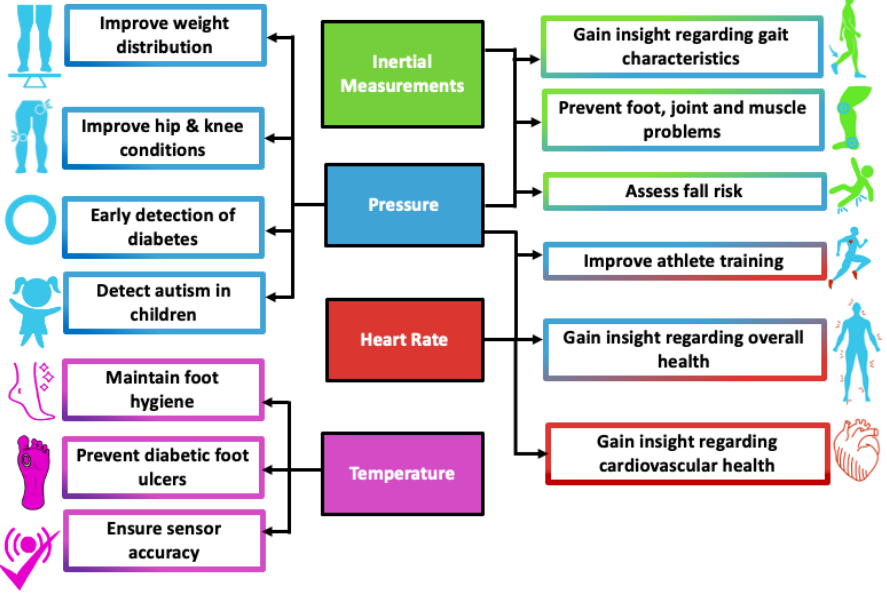
Figure 10. Potential applications of the proposed multi-parameter monitoring insole-based system.